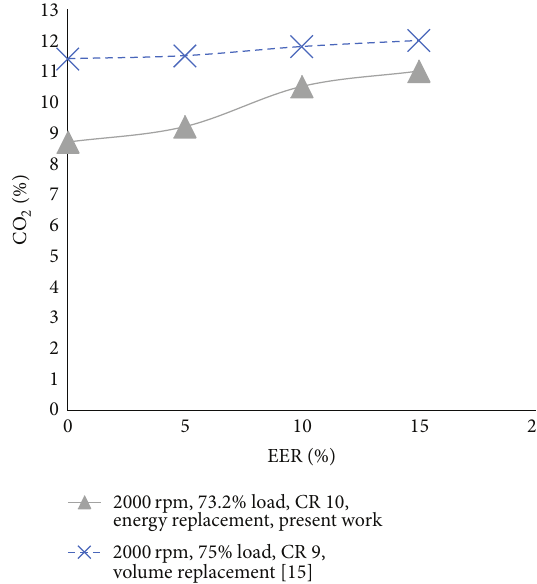
Figure 14: Comparison of present results with results of [15].